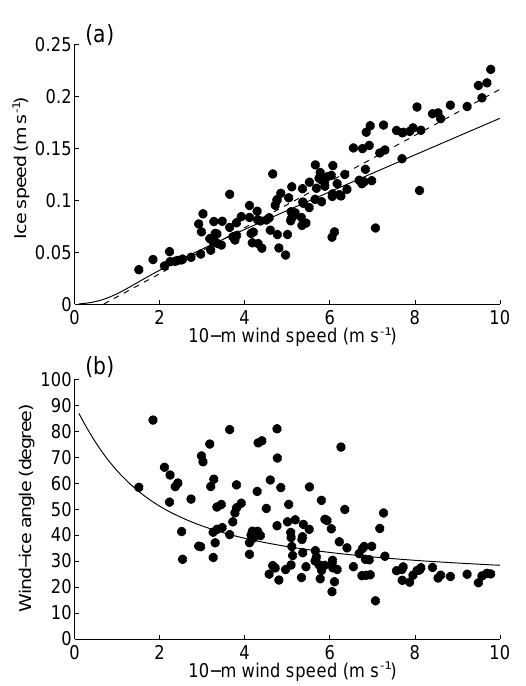
Figure 9. (a) Relationship between 10m wind speed (ms − 1 ) in the ERA-Interim reanalysis data and sea ice speed (ms − 1 ) in the TOPAZ4 reanalysis averaged over a part of the ESS (72–76 ◦ N, 150–170 ◦ E) during 1–31 July 2011–2014. Broken and solid lines indicate the regression line of ice speed on 10m wind speed ( y = 0 . 0224 x − 0 . 0112) and the theoretical ice speed estimated based on classical free-drift theory. (b) Angle (degrees) of sea ice velocity relative to surface wind vectors averaged over the ESS. Positive val- ues indicate that sea ice drift is to the right of the wind direction. Solid curve indicates the wind–ice velocity angle estimated based on classical free-drift